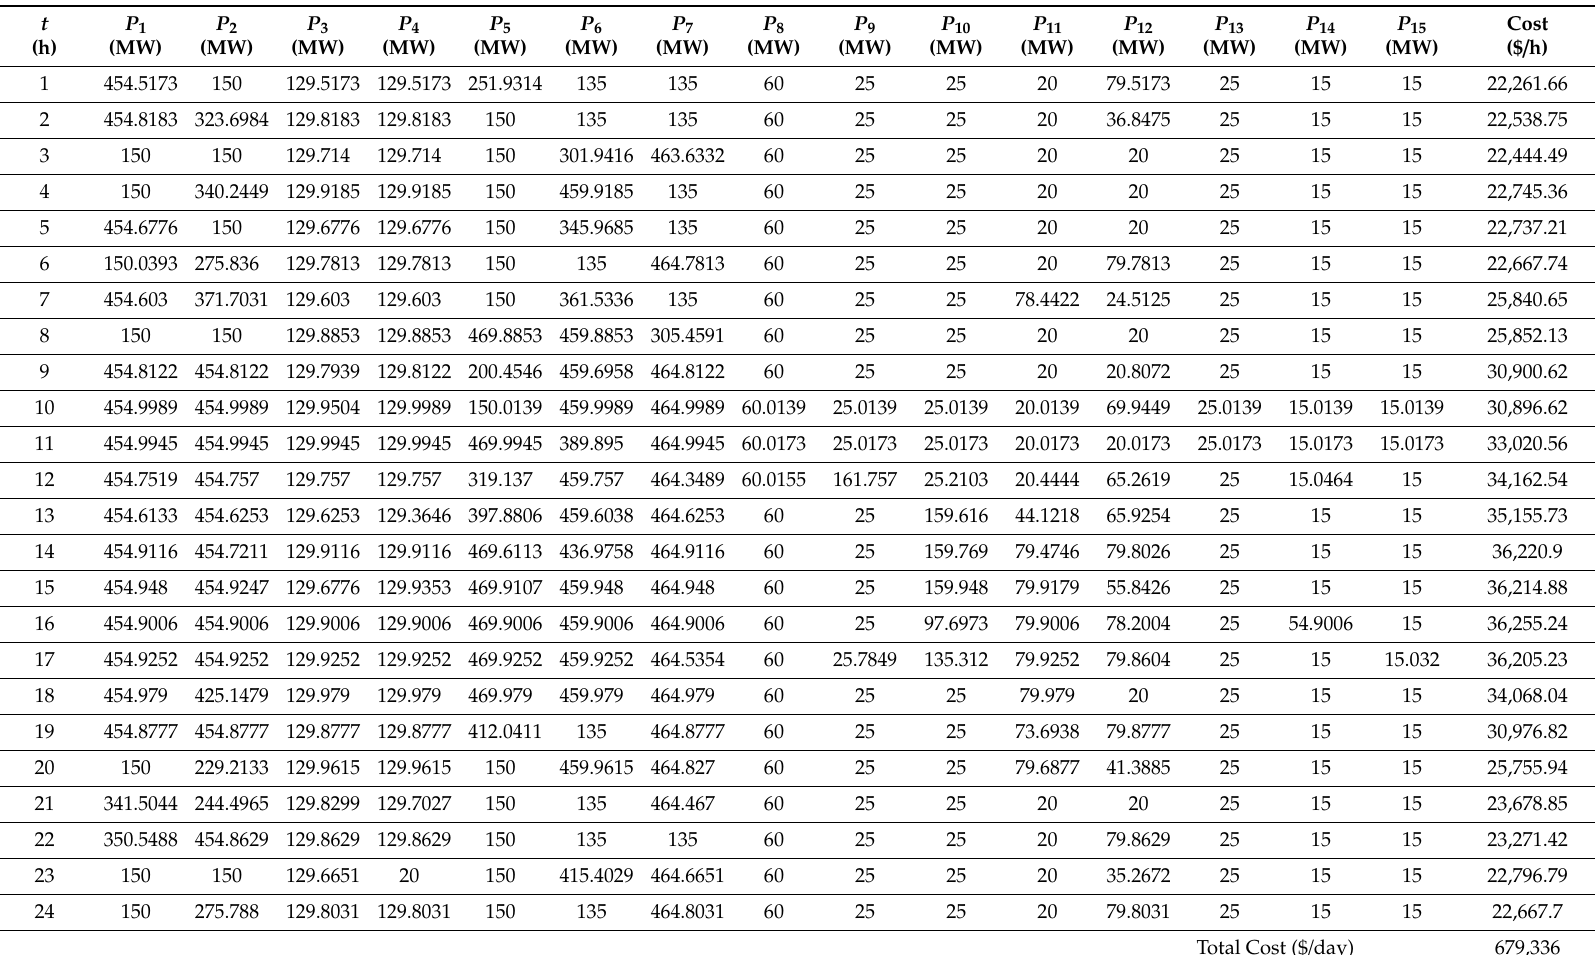
Table 9. The BA on a 15-unit system without